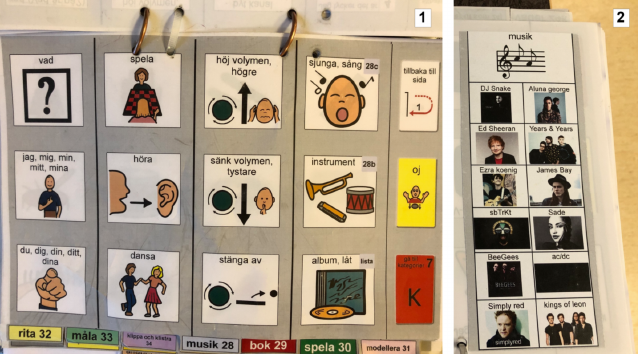
Figure 2. Pages dedicated to music-related concepts in a PODD book. Figure 1 (left) describes the following concepts using both pictures and text fields (intended for the teachers, since the students do not read): top row: what, play, raise the volume, sing/song, go back to page; middle row: me/my/mine, hear, lower the volume, instrument, whoa; bottom row: you/yours, dance, turn off, album/song, go to categories. Figure 2 (right) shows picture representations of one of the student’s favorite music